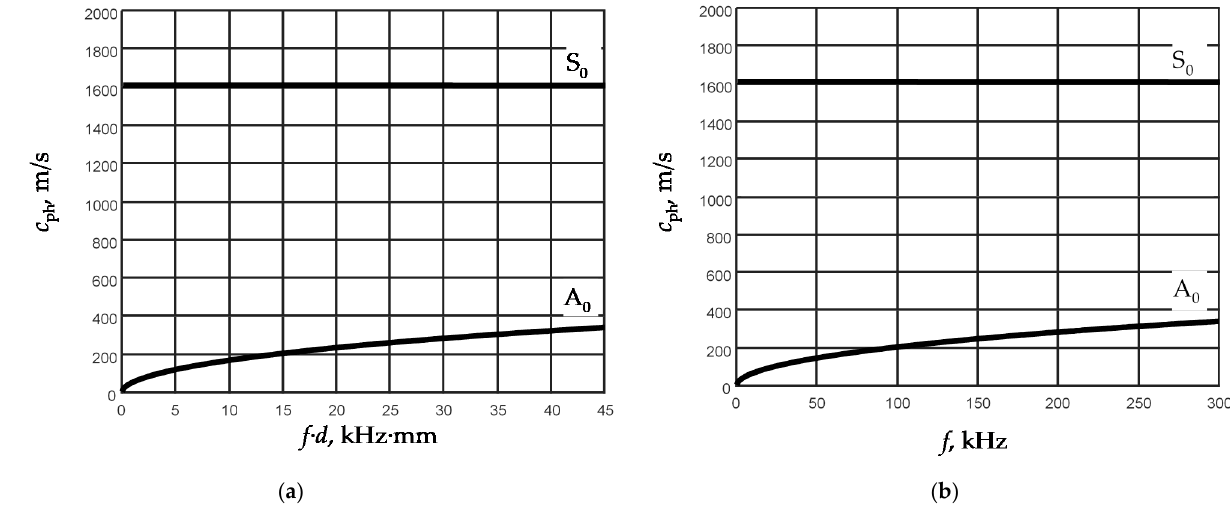
Figure 1. Phase velocity dispersion curves of Lamb wave fundamental modes calculated by SAFE method: ( a ) versus f · d , kHz·mm; ( b ) versus frequency f in d = 150 µm thickness PVC film.